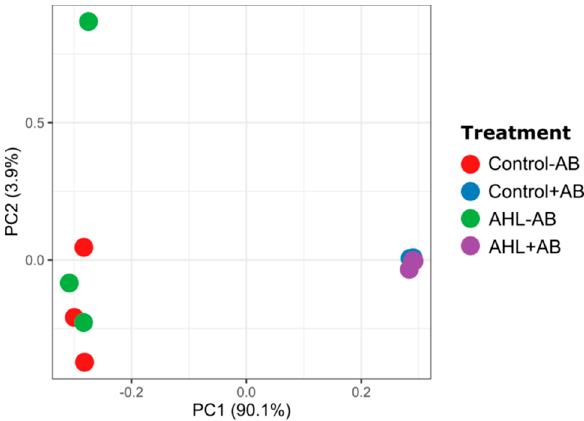
Figure 8. Bacterial community structures of bacteria associated with four-day-old Medicago roots with different treatments. Principal component analysis (PCA) showed a difference in the bacterial community structures between the treatments ( n = 3). AB = antibiotic treatment; AHL = 3-oxo-C 14 -HSL treatment.